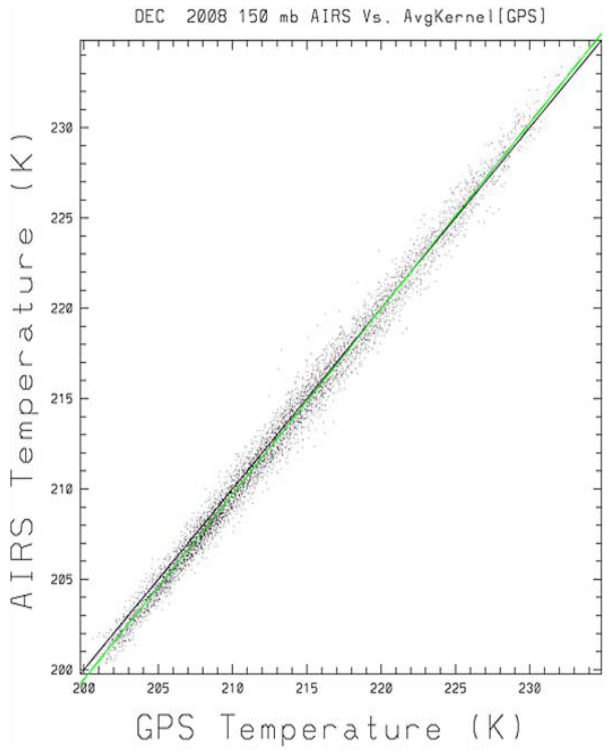
Fig. 34. Correlation of AIRS and COSMIC temperatures (K) at 150hPa for December 2008. AIRS temperatures are slightly lower (higher) than COSMIC temperatures for lower (higher) tempera- tures (Ho et al., 2010b).